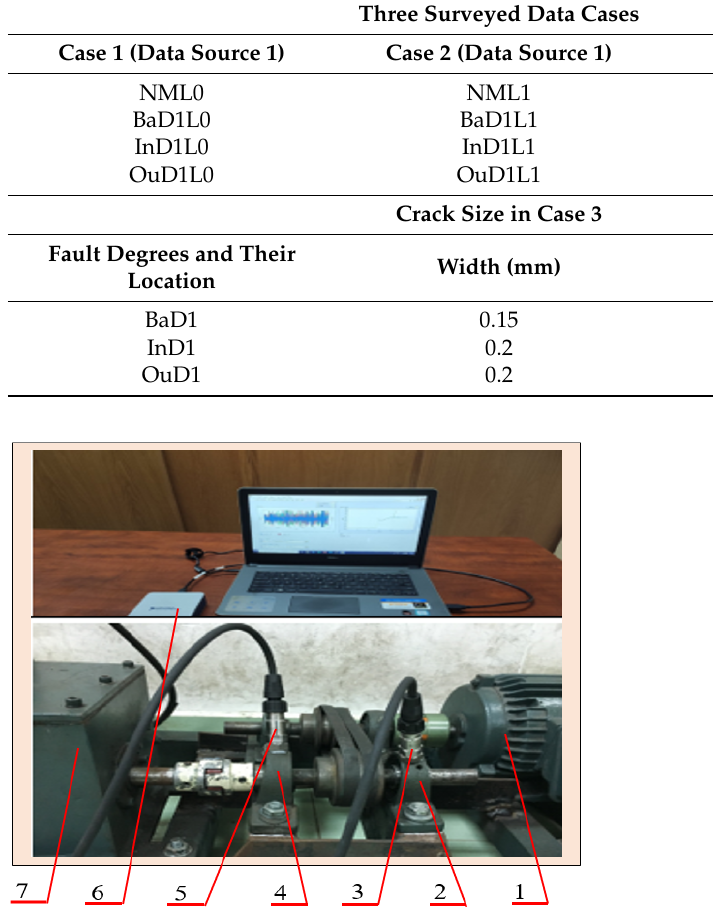
Table 2. Three surveyed data cases and crack sizes in Case 3.